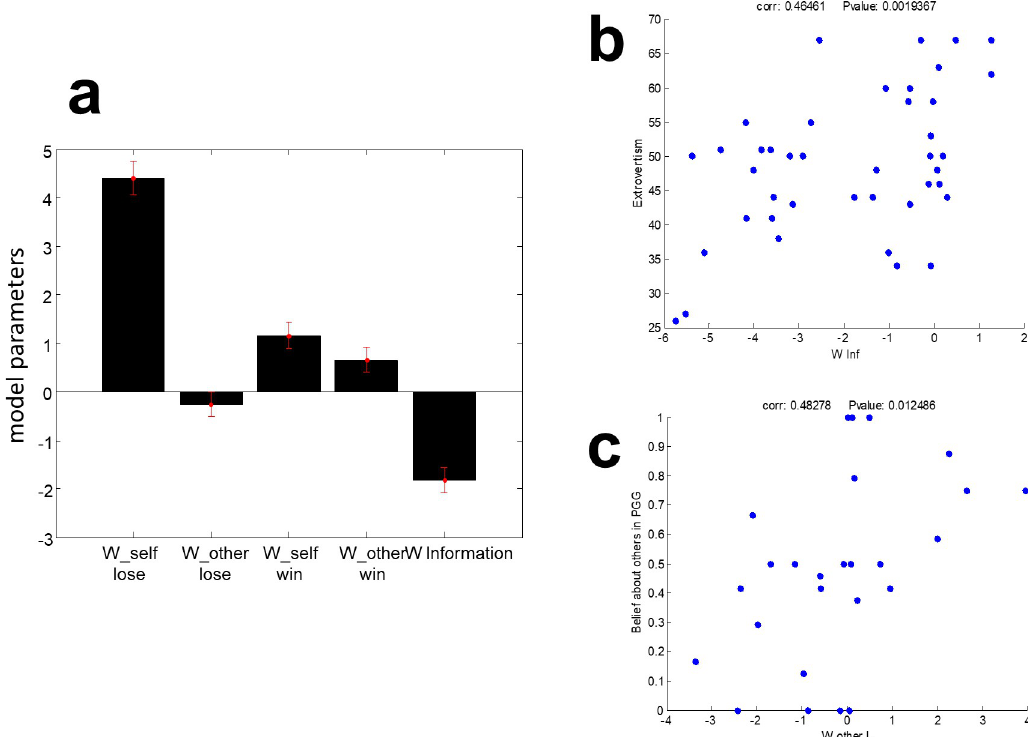
Fig 5. Proposed model parameters’ mean and SEM plus correlation with PGG and Big Five personality traits. a) mean and SEM of model parameters. Note that w self _ win = w self_lose + w self_change and w other_win = w other_lose + w other_change . b) there is a positive correlation between sensitivity to the probability of PasSub’s winning and subjects extraversion. c) positive correlation between subjects’ other-regarding behavior in the loss condition and their belief about others’ cooperation in Public Goods Game (PGG).